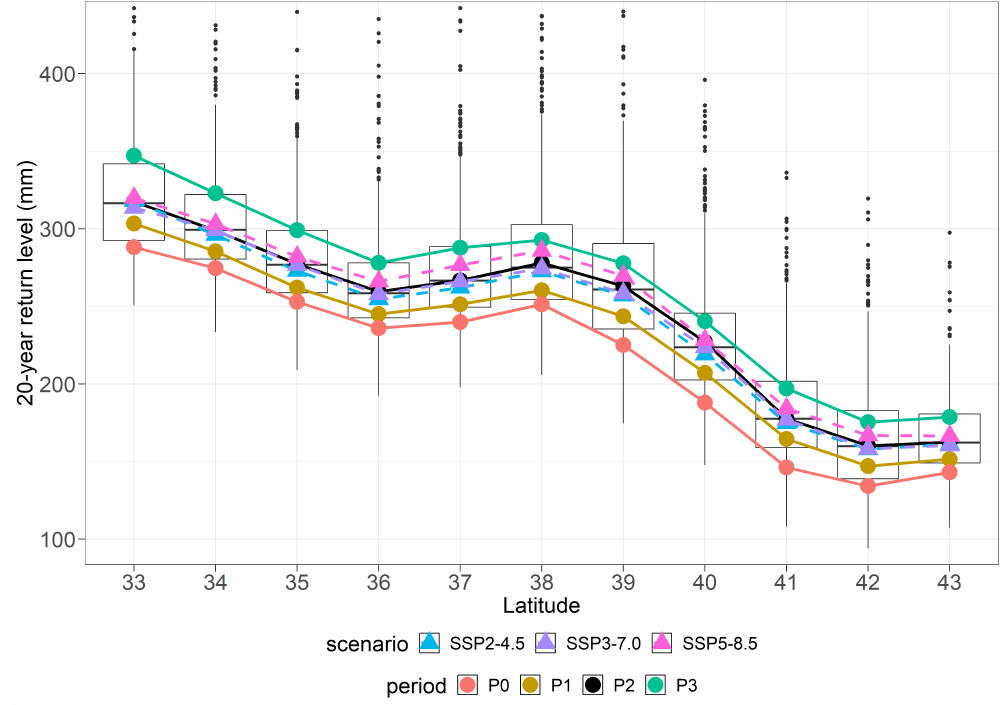
Figure 13. Boxplots of the 20-year return levels (unit: mm) from the 21 CMIP6 models as the latitude changes from 35 ◦ to 42 ◦ . The solid lines around the boxes across the latitude are the spatial medians of 20-year return levels for each latitude and for P0 (1973–2010, i.e., the observation period), P1 (2021–2050), P2 (2046–2075), and P3 (2071–2100). The dashed lines depict those values for the three scenarios (SSP2-4.5, SSP3-7.0, and